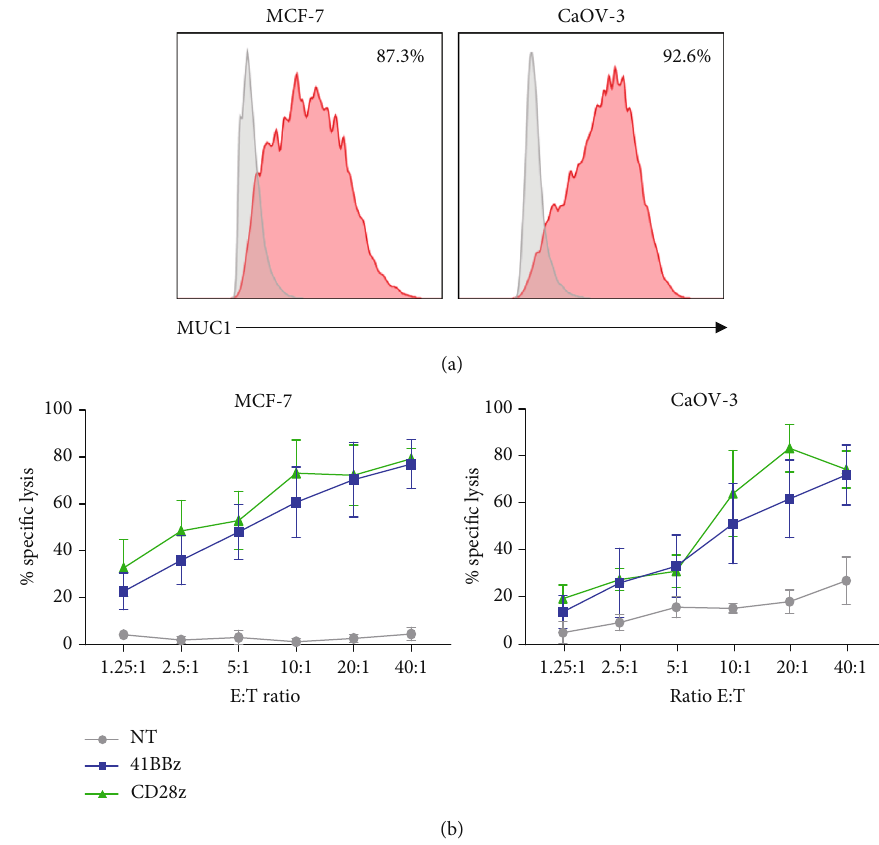
Figure 2: Speci fi c lysis of CAR T cell targeting tumor associated MUC1. (a) Expression of MUC1 on di ff erent cancer cell lines, MCF-7 and CaOV3. (b) Six-hour cytotoxicity assay at E:T ratio 40 :1, 20 :1, 10:1, 5:1, 2.5:1, and 1.25:1. Target cells: MCF-7 (left) and CaOV3 (right). The data shown are mean ± S : E : M from four donors. Signi fi cance was determined by one-way ANOVA, ∗ for P < 0 : 05 , ∗∗ for P < 0 : 01 , and ∗∗∗ for P < 0 : 001